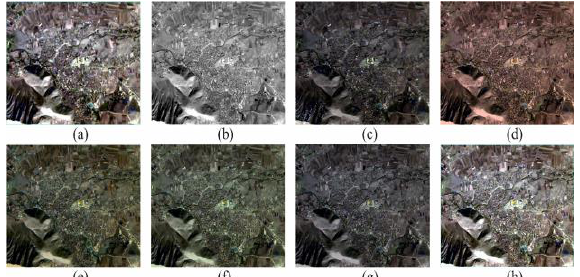
Figure 2. Qualitative results of Landsat-8 dataset a) MS, b)